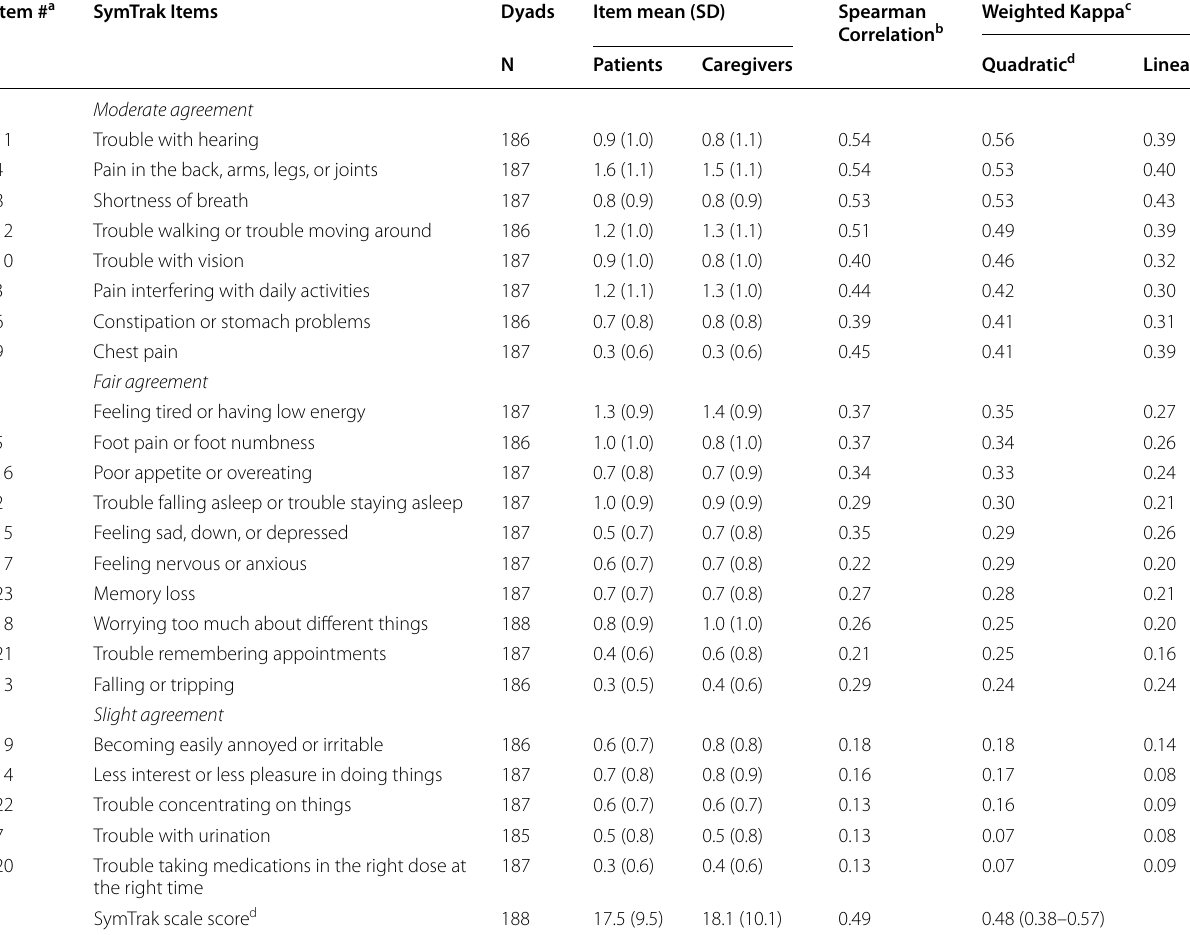
Table 3 Patient-Caregiver Concordance for SymTrak